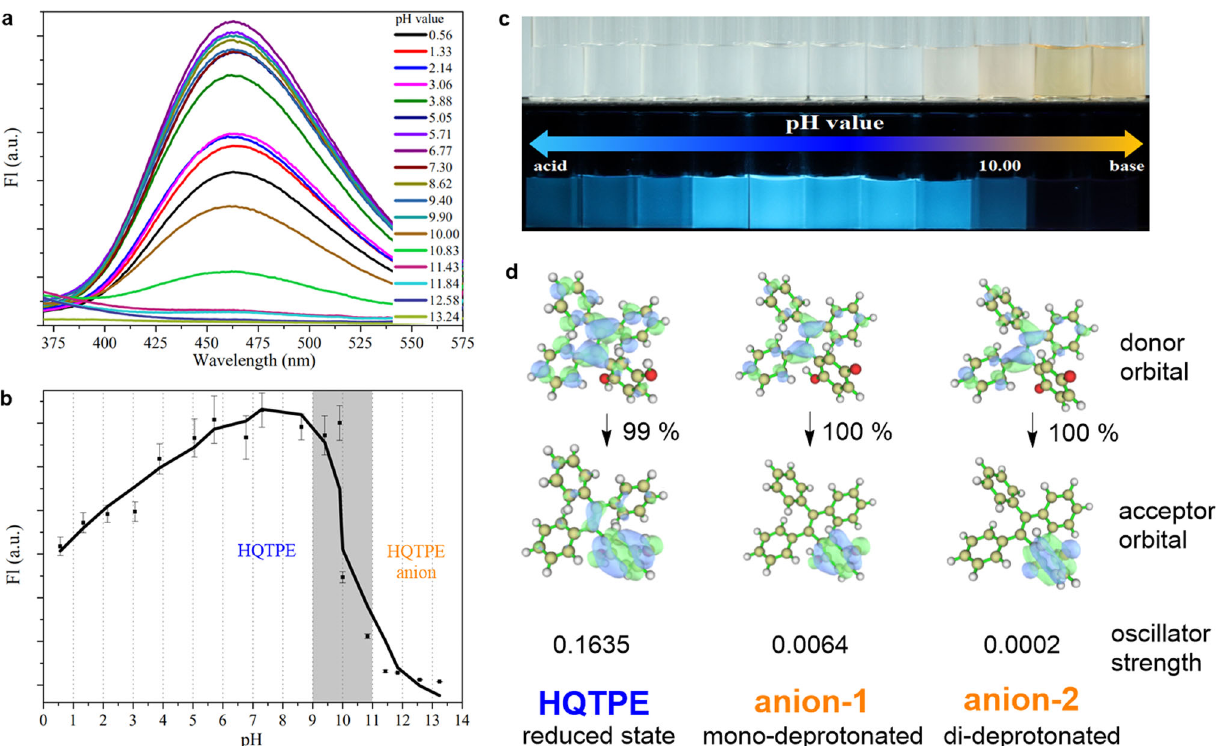
Fig. 6 Detection of pH value. a Fluorescence responses of 100 μ M HQTPE to different pH values at excitation wavelength of 300 nm. b Fitting curve of the fl uorescence intensity of HQTPE solutions under various pH conditions. Error bars show SDs of three independent measurements. c Photographs of HQTPE solutions at different pH conditions under white light or excited by UV light. d The natural transition orbitals (NTO) pairs describing S 0 – S 1 transition and corresponding oscillator strength of HQTPE and corresponding anions. Numbers near the arrow indicate the contribution percentage of displayed NTO transitions to the corresponding S 0 – S 1 transitions. Calculated at optimized S 1 geometry using TD-DFT method.